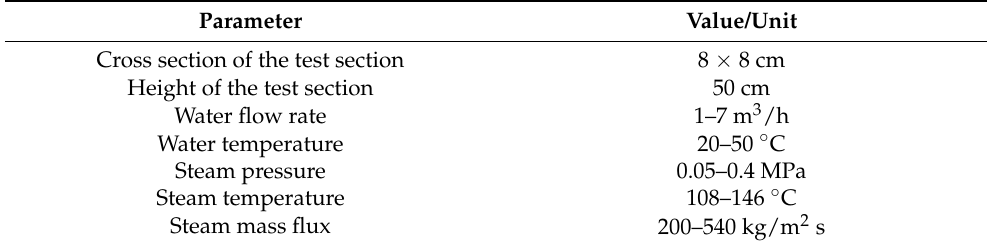
Table 5. The test conditions in